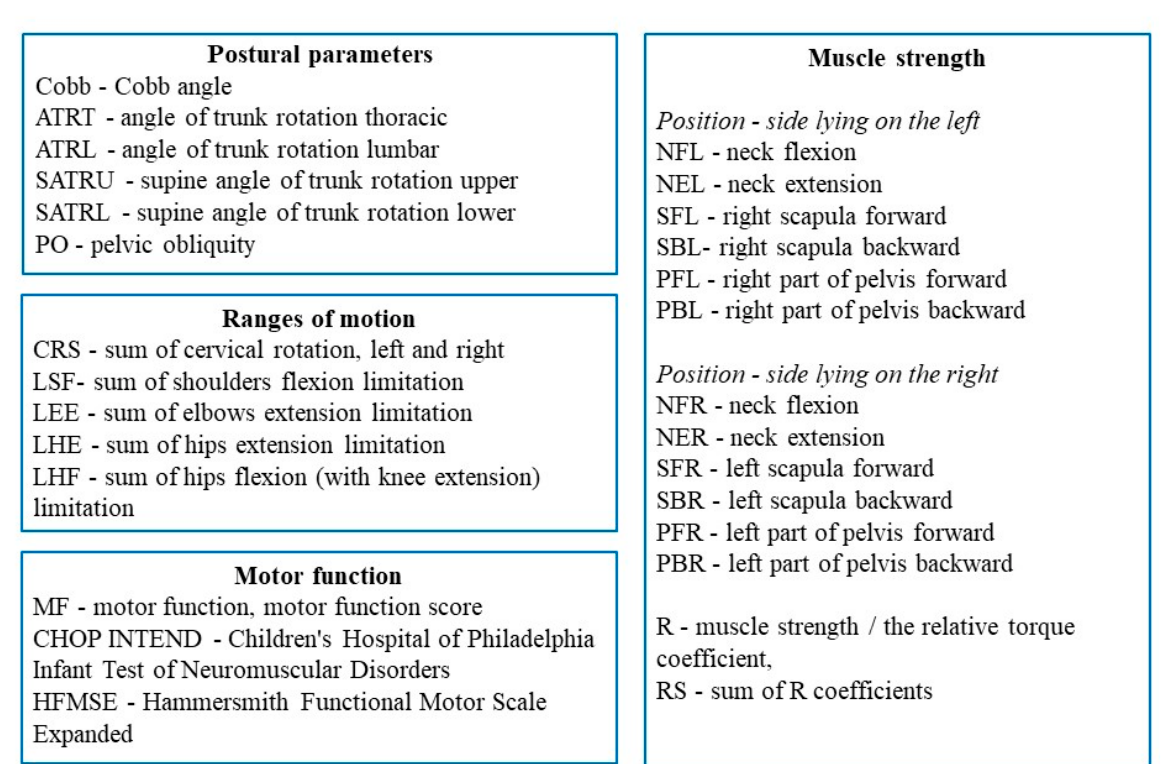
Figure 1. Motor function, range of motion, postural, and muscle strength measurements with abbreviations.